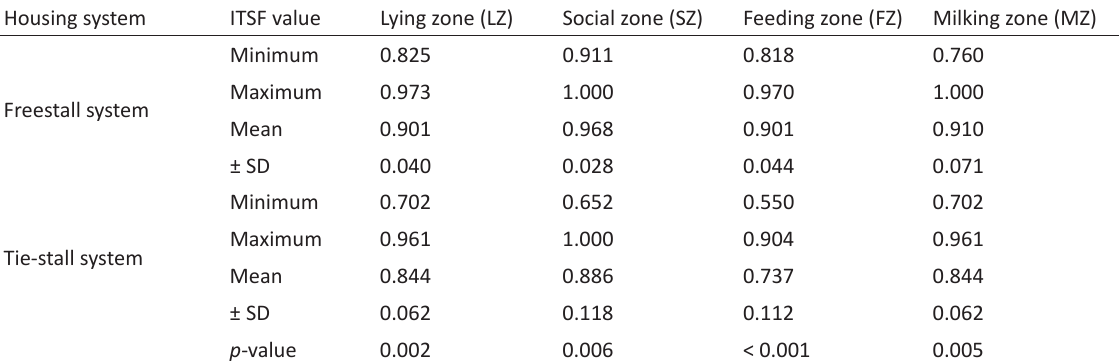
Table 3. ITSF mean values ± SD for the set of investigated barns and their selected traits, i.e., housing system and zone type, including p -value Housing